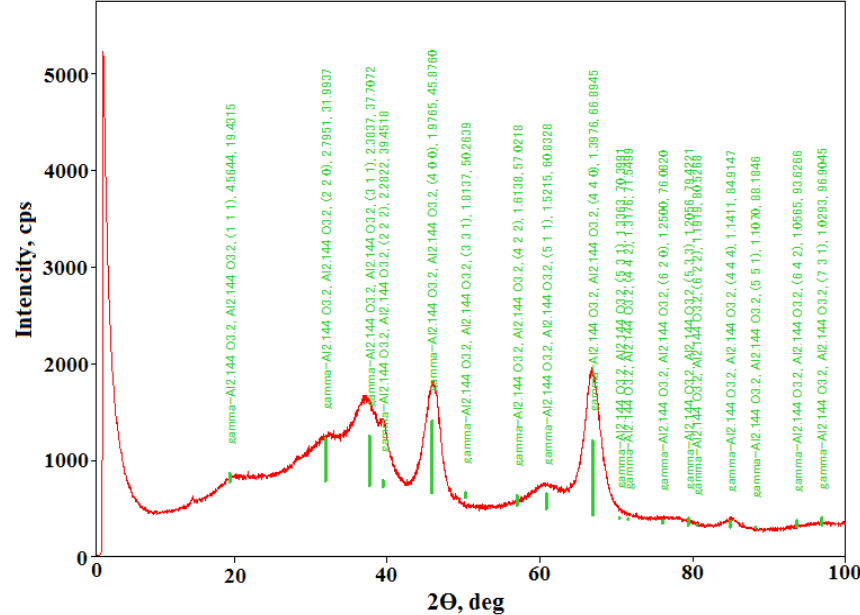
Figure 3. XRD pattern of modeled γ -aluminum oxide.